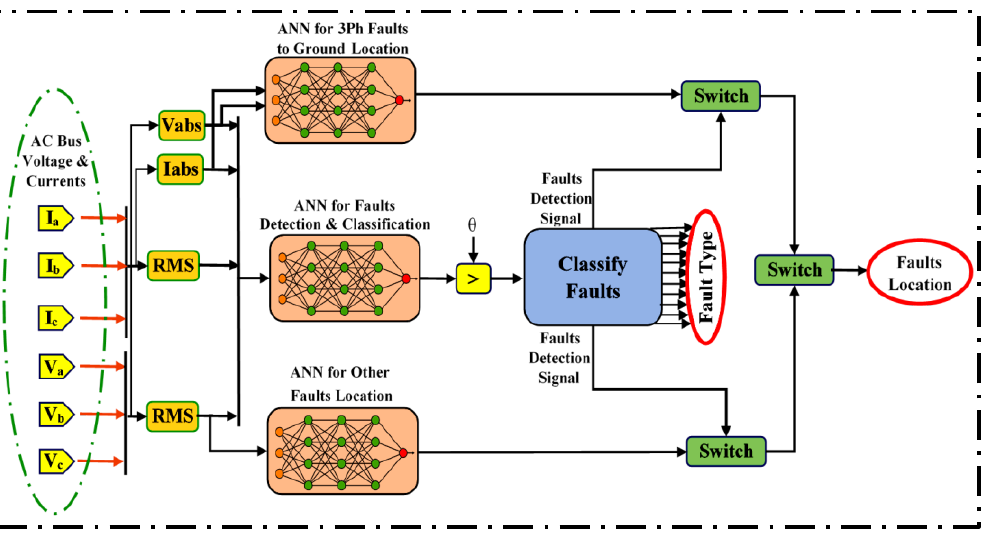
Figure 7. ANN-based schematic representation for fault detection, classification, and location.